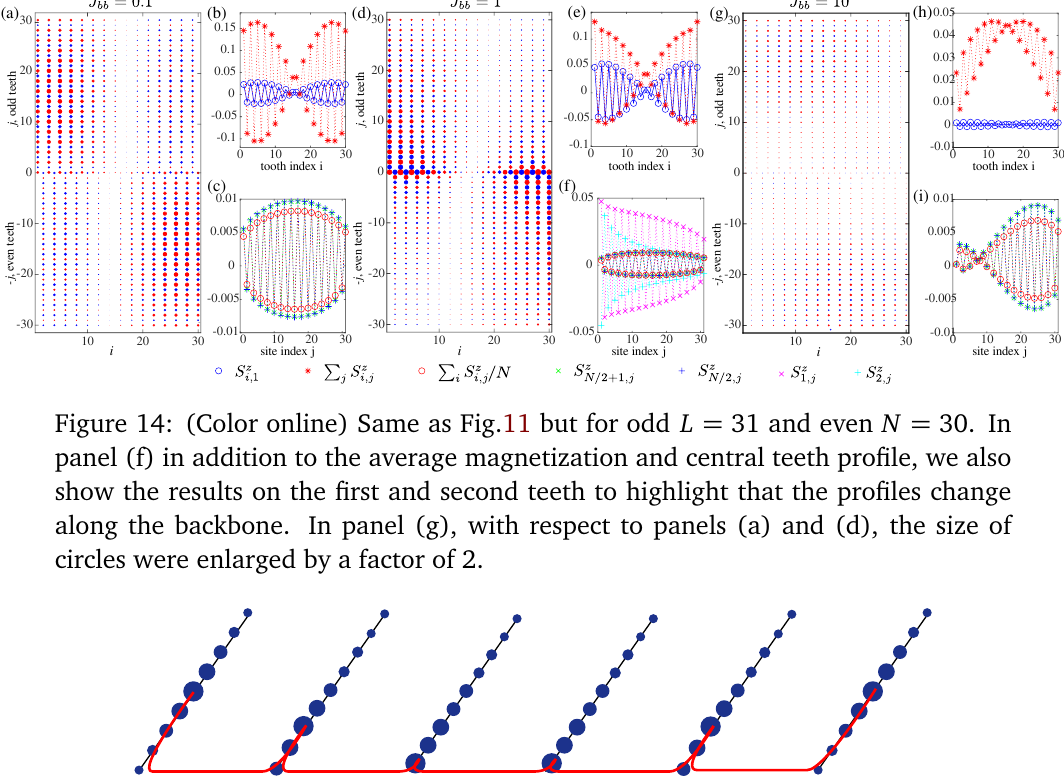
= 1 / 2. In panel (g), with re- tot